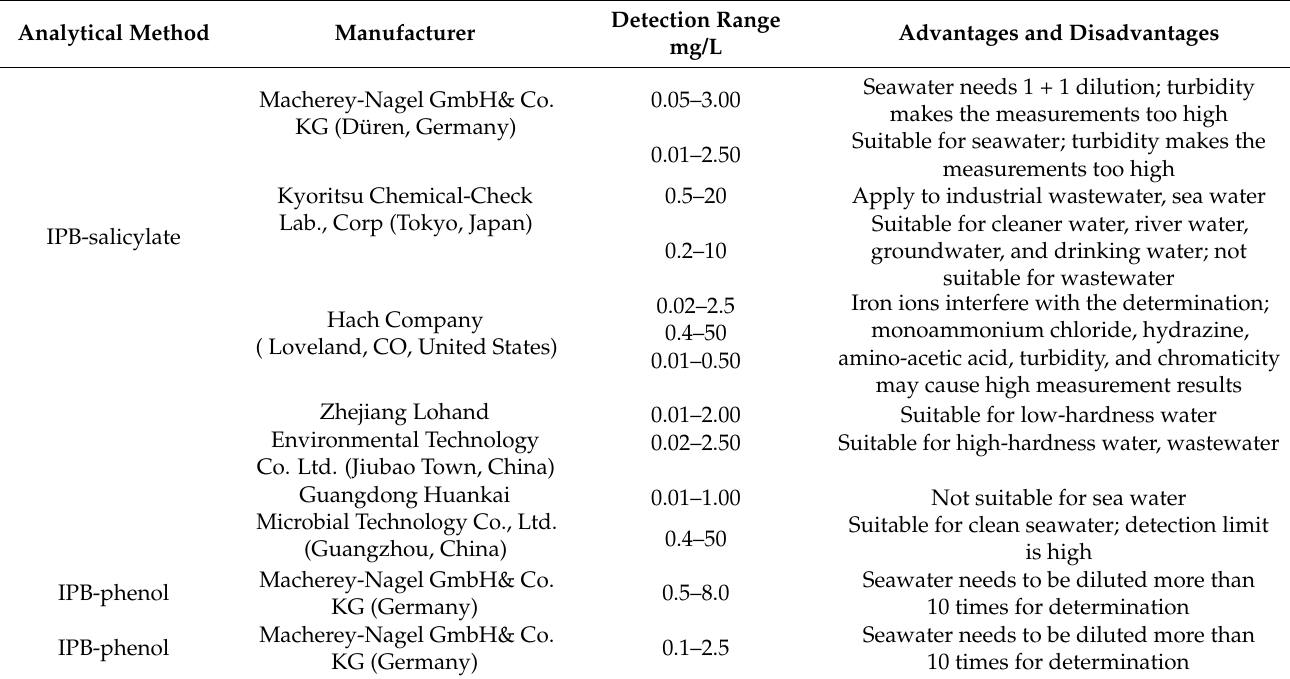
Table 1. Some ammonium ion test